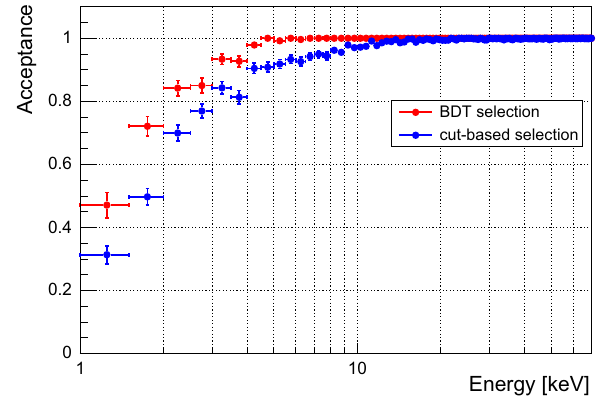
Fig. 6 BDT classifier output for data acquired with the 226 Ra source (blue) and background data (red), with superimposed cut threshold (black dashed line)